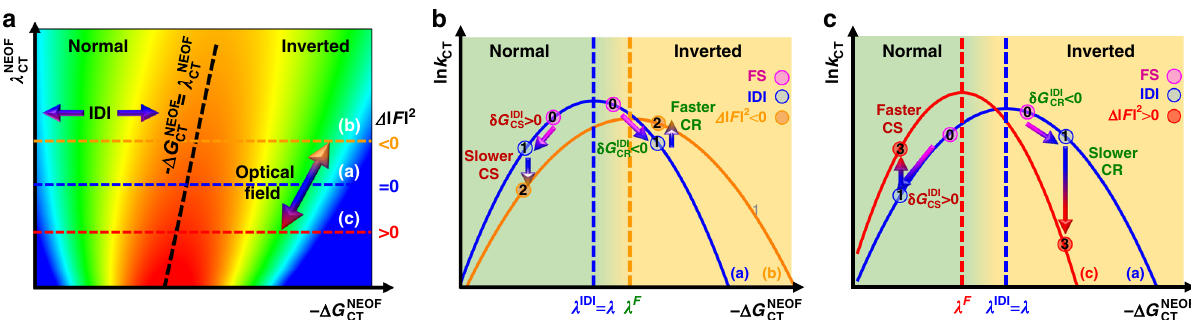
Fig. 8 Calculated charge-transfer rate on Marcus parabola diagrams. a False-color plot of the charge-transfer (CT) rate logarithm as a function of the driving force and the reorganization energy. The horizontal and tilted arrows illustrate to the effect of image-dipole interactions (IDI) and of the optical fi eld intensity, respectively. The horizontal and tilted dashed lines represent three iso-optical fi eld cross-sections, and the borderless zone, respectively. Cross- sections of a lead to b Δ | F | 2 < 0 and c Δ | F | 2 > 0. The vertical dashed lines show the borderless points. The bicolor arrows and circled labels illustrate shifts of the charge-transfer dynamic on fused silica (0) under the nonlocal image-dipole-interaction (IDI) effect (1) and nonlocal enhanced optical fi eld effects (2-3), as described in Figs. 6b